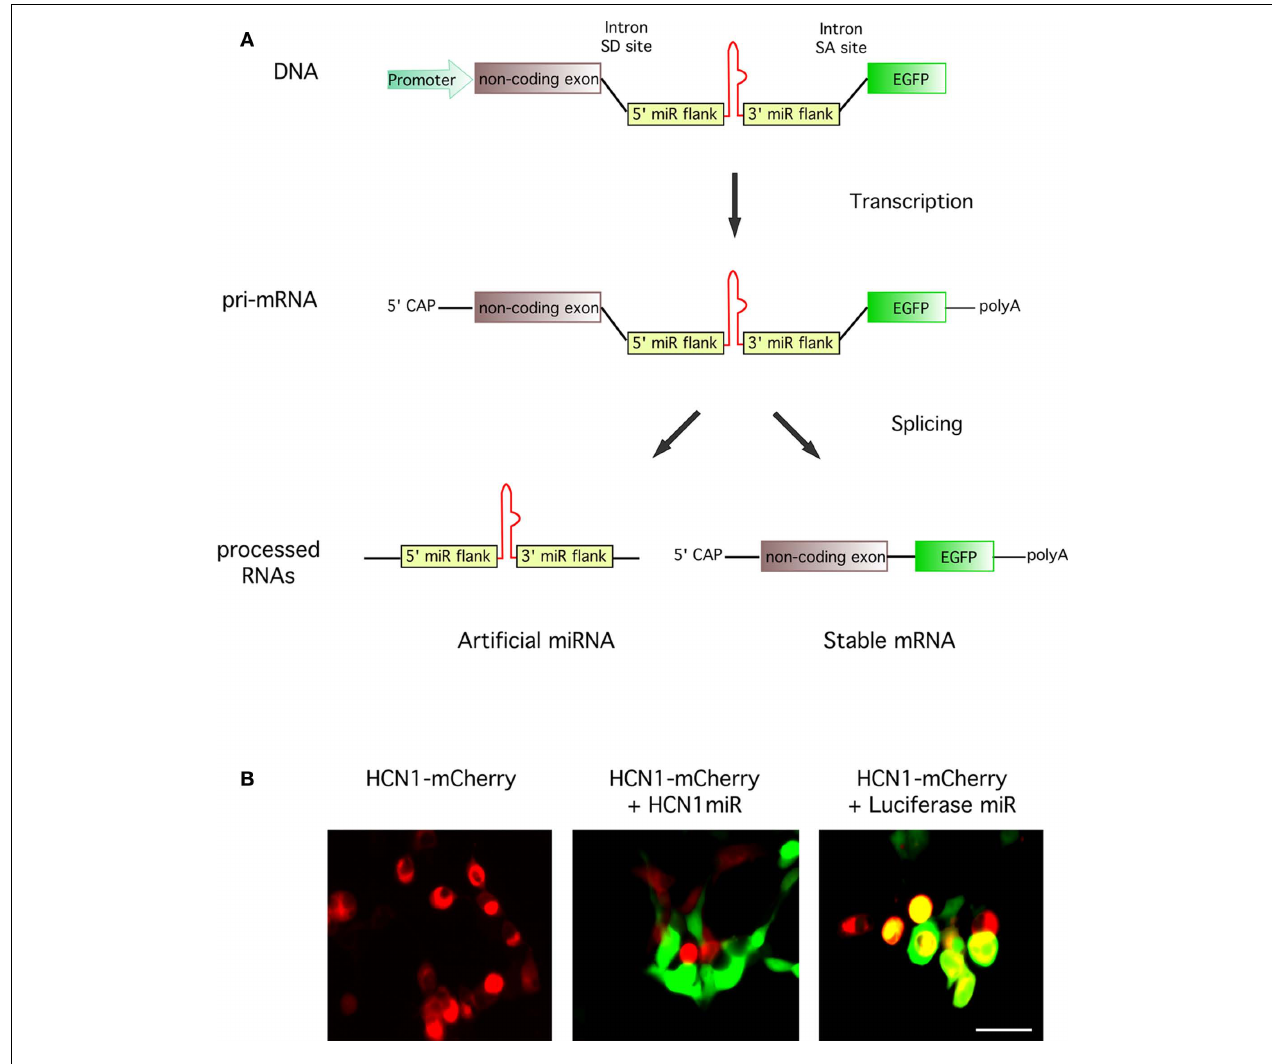
testing of an intronic miRNA construct targeting expression of HCN1 . HEK293FT cells were transfected with plasmids expressing HCN1-mCherry (red) alone or as a cotransfection with a vector encoding a miRNA targeting either HCN1 (pSM155-HCN1miR) or luciferase (pSM155-LucmiR; green).Transfection with the HCN1 miRNA reduced expression of HCN1-mCherry whereas the luciferase miRNA did not. Scale bar = 50 μ